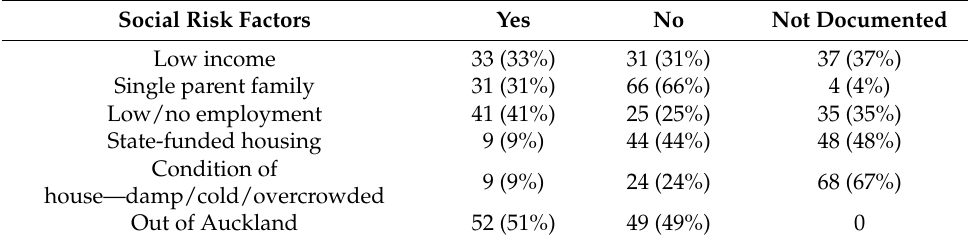
Table 3. Social–economic risk factors documented per